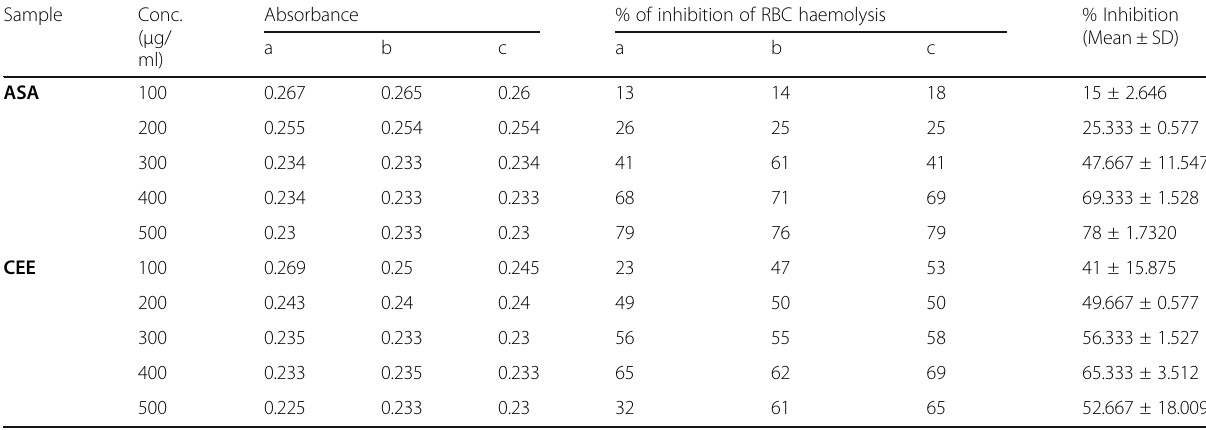
Table 1 Effect of CEE and ASA on heat-induced hemolysis of RBC membrane